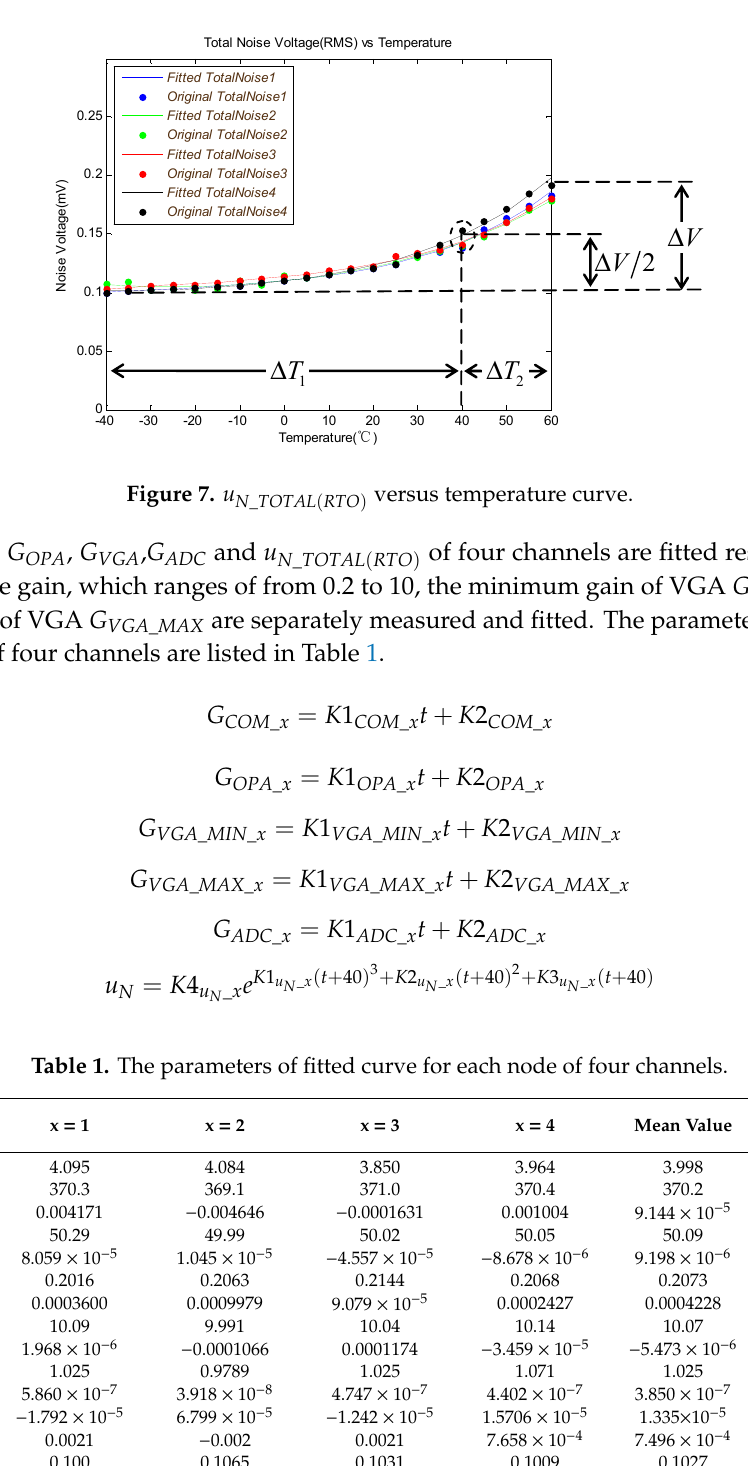
Table 1. The parameters of fitted curve for each node of four channels.